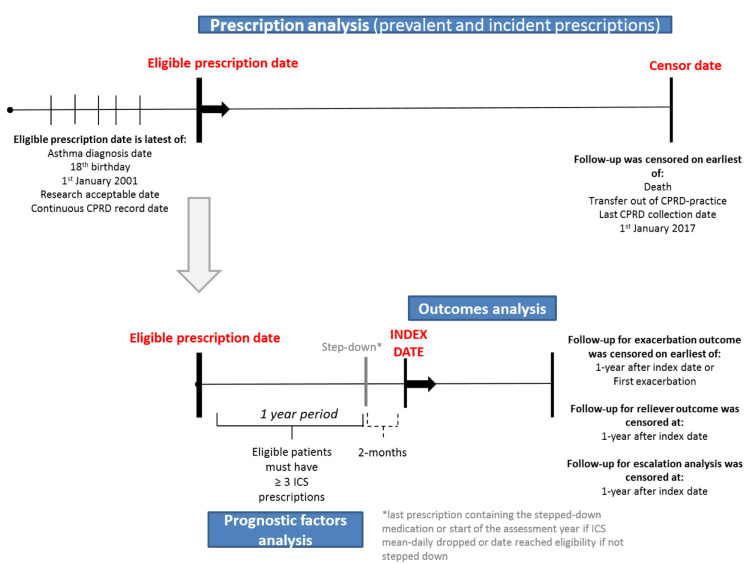
Flow diagram for study.CPRD, Clinical Practice Research Datalink; ICS, inhaled corticosteroid